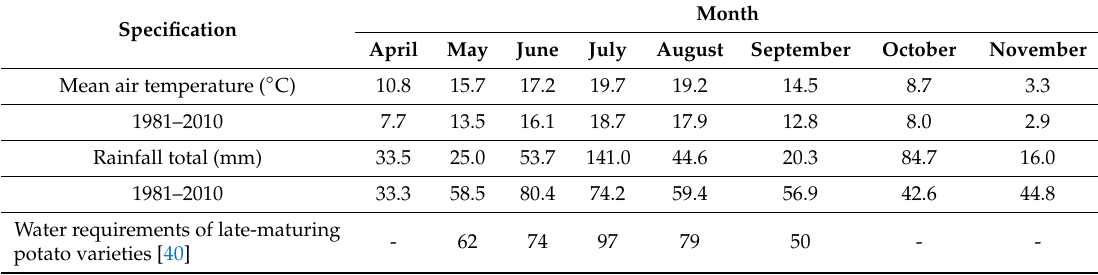
Table 2. Meteorological data for the growing season of 2018 and long-term average for 1981–2010.